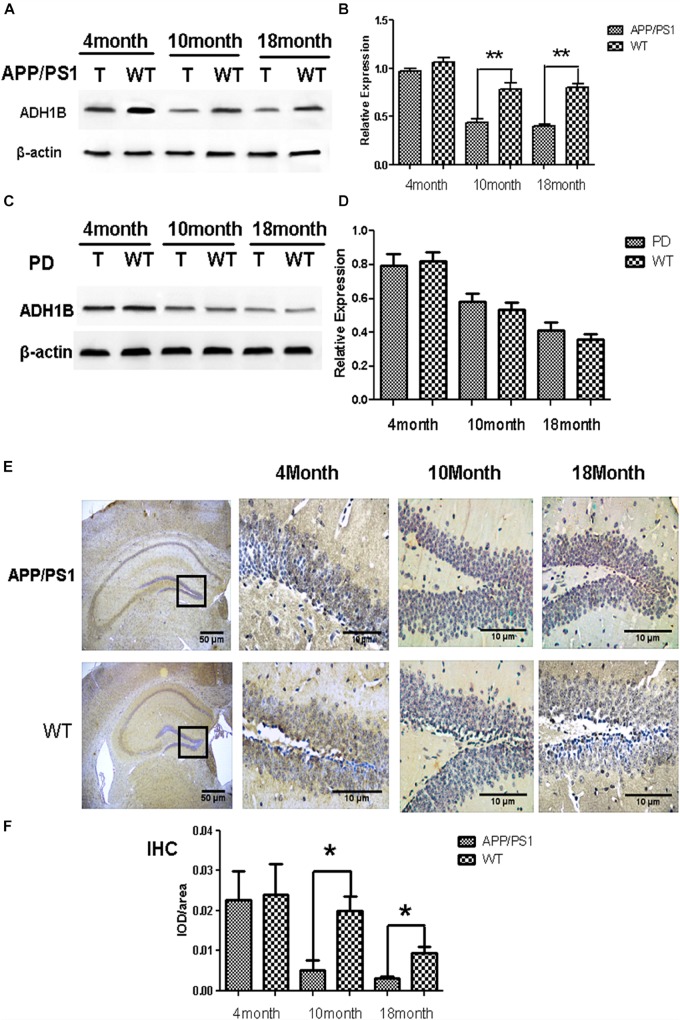
Alcohol dehydrogenase 1B (ADH1B) in the hippocampus of Alzheimer’s disease (AD) and Parkinson’s disease (PD) model mice at different ages. (A) Representative ADH1B polypeptides detected in the hippocampus of APP/PS-1 AD model mice with 4 (4T), 10 (10T), and 18 (18T) months of age. Negative controls with similar ages (4WT, 10WT, and 18WT) were used. Proteins were extracted from the hippocampus of model mice and then analyzed using western blotting. (B) Relative expression of ADH1B in the hippocampus of APP/PS-1 AD model mice (n = 8 per group, two-way ANOVA). (C) Representative signals of ADH1B in the hippocampus of Prnp-SNCA*A53T PD model mice. (D) Relative expression of ADH1B in the hippocampus of Prnp-SNCA*A53T PD model mice (n = 8 per group, two-way ANOVA). β-Actin was used as a loading control. (E) Immunohistochemical staining of paraffin sections of mouse brain tissue using anti-ADH1B antibody (n = 4 per group). Red arrows, ADH1B-positive regions. Scale bar, 50 μm. (F) Relative expression of ADH1B in the hippocampus determined using immunohistochemical staining (Chi-square tests). Data are shown as mean ± S.D. *p < 0.05 and ∗∗p < 0.01.